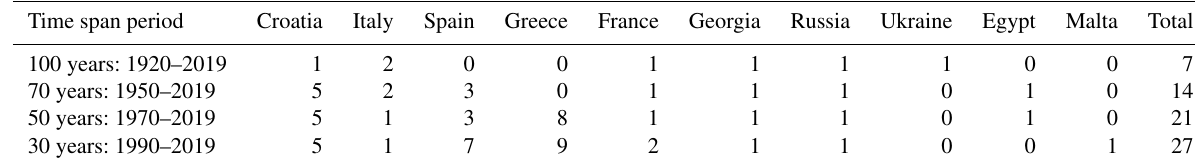
Table 1. Number of stations per country available for the different time spans of 30, 50, 70, and 100 years in the PSMSL sea level trend online product.